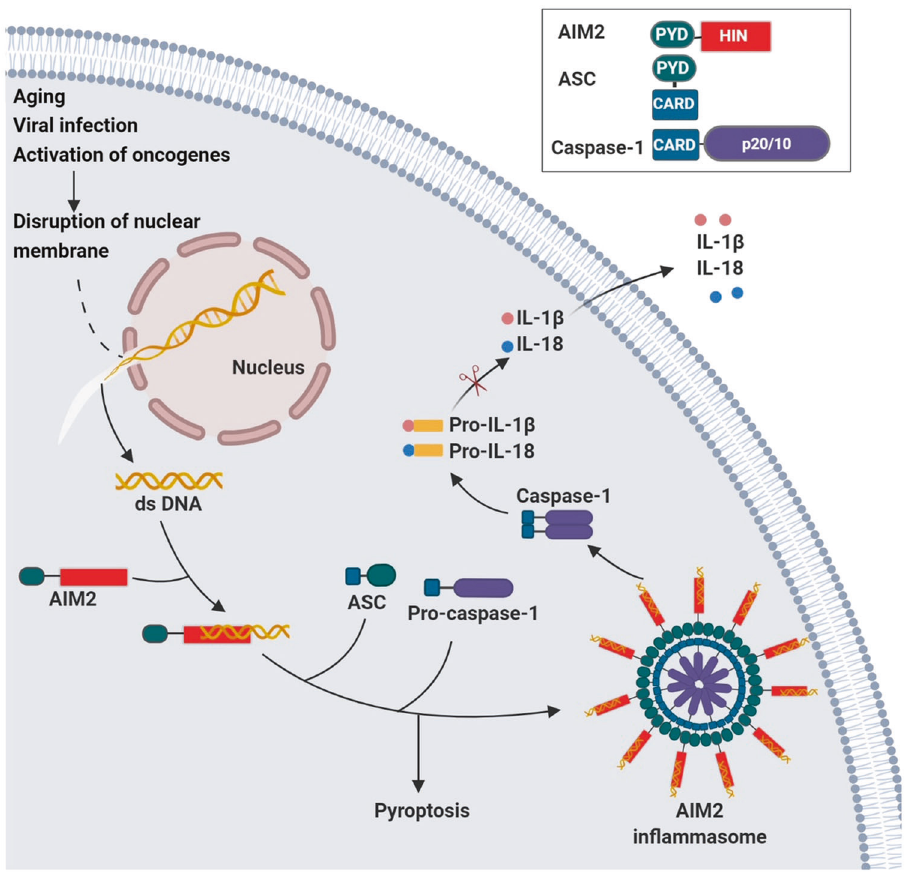
Fig. 3 The formation and activation of AIM2 in fl ammasome. The HIN domain of AIM2 binds dsDNA in the cytosol. AIM2 binds to ASC through PYD – PYD interaction. The in fl ammasome is formed through AIM2-ASC oligomerization. Pro-caspase-1 is recruited by ASC via CARD – CARD interaction. Inset: AIM2 in fl ammasome